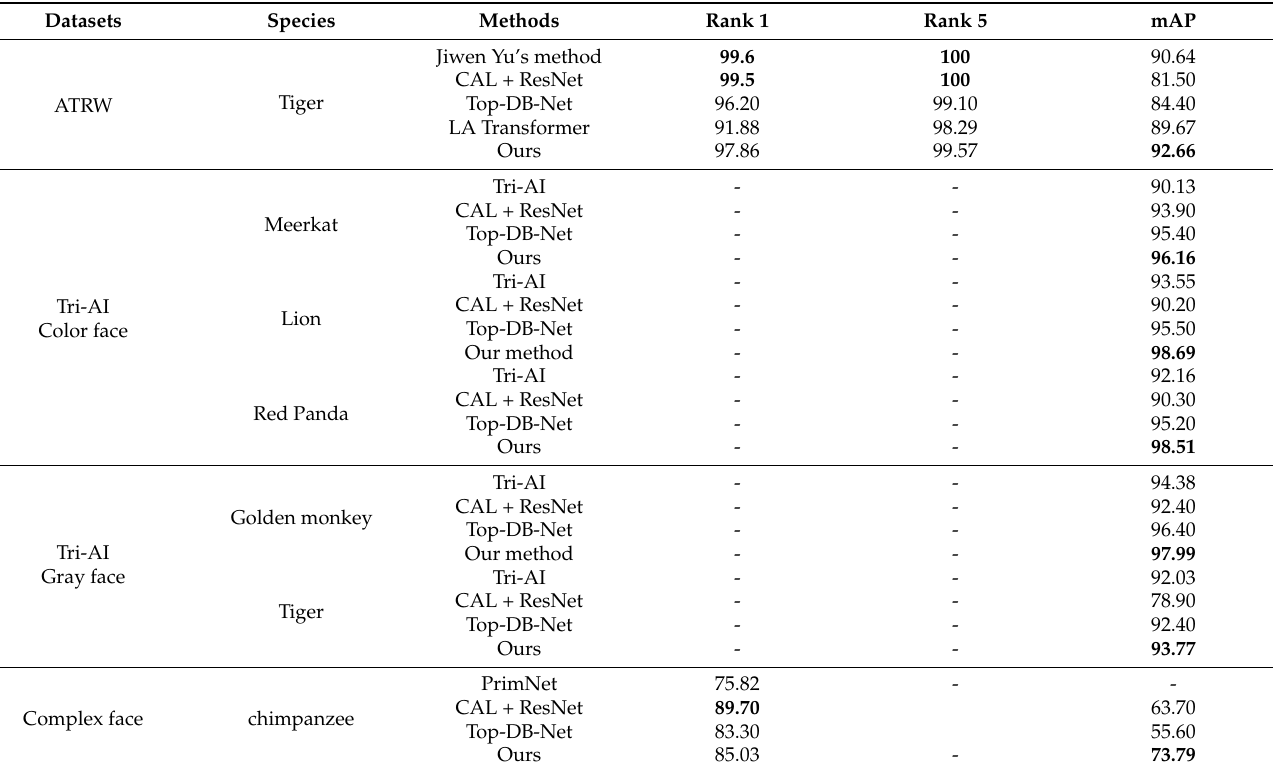
Table 2. Experimental results of different